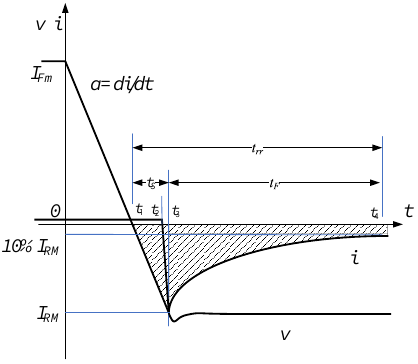
Figure 2. Turn-off process of the diode.